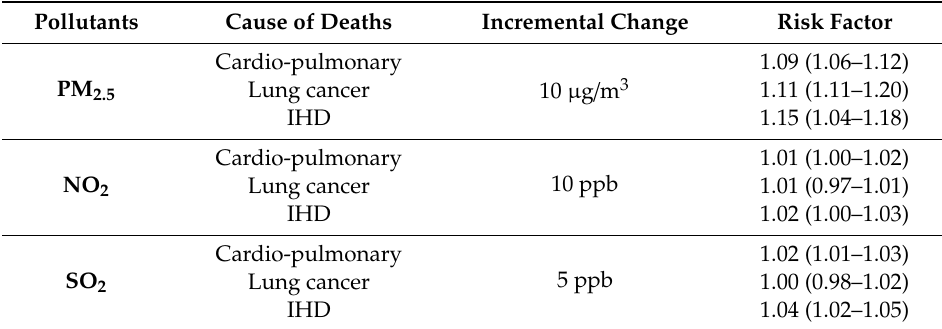
Table 3. The relative risk of pollutants and selected cause of deaths